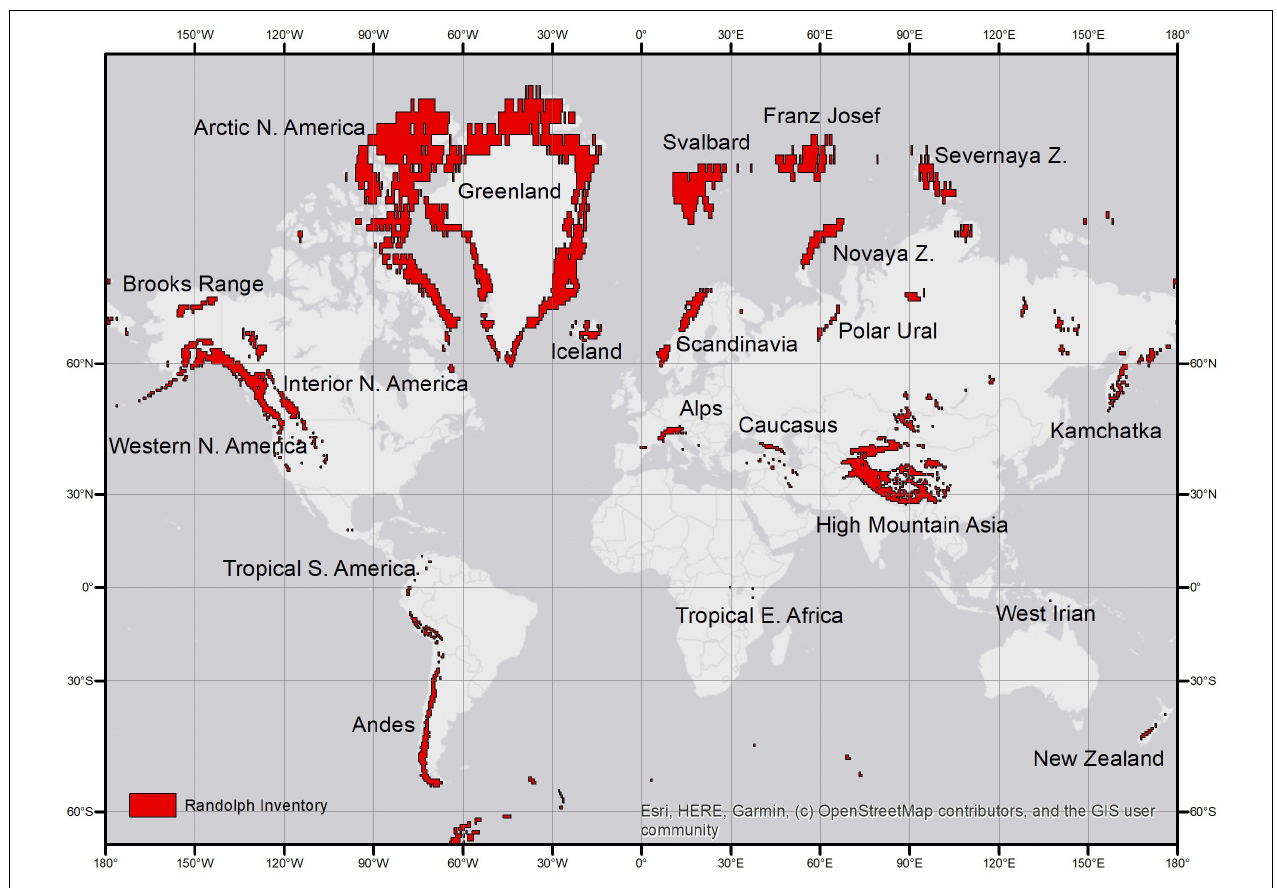
FIGURE 1 | Simplified geography of early twenty-first century glaciers. The highlighted half-degree latitude/longitude squares contain glaciers according to the Randolph Glacier Inventory (RGI Version 6) (Pfeffer et al., 2014; RGI Consortium,